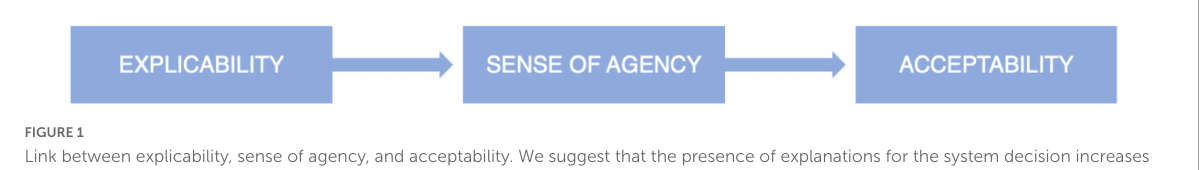
FIGURE1 Link between explicability, sense of agency, and acceptability. We suggest that the presence of explanations for the system decision increases the user’s sense of agency, which in turn increases the acceptability of the system itself.